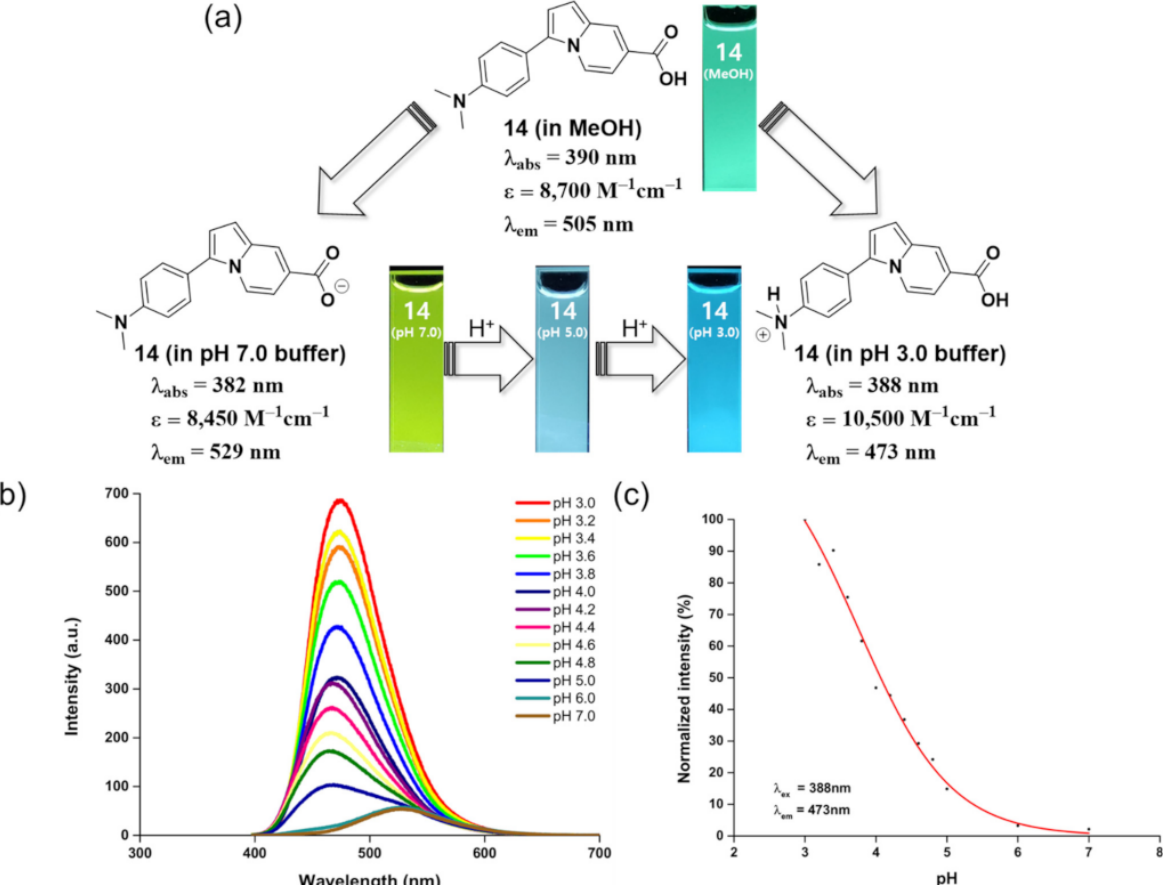
Figure 5. pH response of compound 14 . ( a ) Photophysical properties and visible color change of compound 14 in MeOH, pH 7.0, 5.0, and 3.0 buffer solution. The fluorescence photo images of compound 14 were taken under 365 nm UV light irradiation. ( b ) Emission spectra of compound 14 at different pH buffer solution measured with excitation wavelength at 388 nm. ( c ) Scatter plots of the normalized fluorescence emission intensity of compound 14 over the pH range 3–7 with an excitation/emission wavelength at 388/473